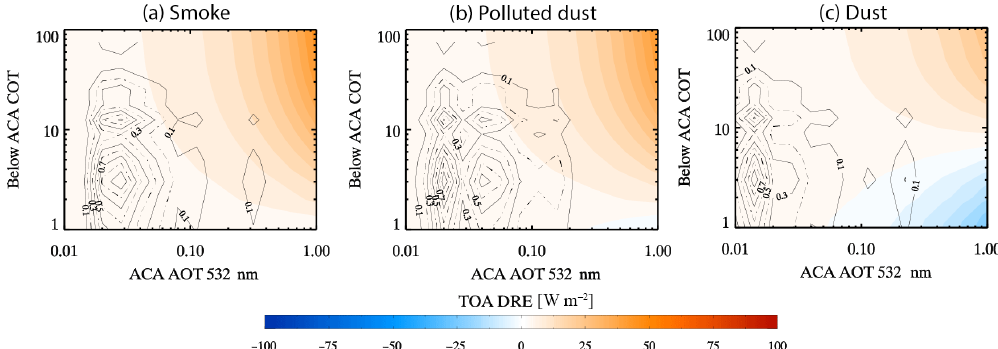
Figure 13. Same as Fig. 9 but for the (a) smoke, (b) polluted dust and (c) dust aerosols in the Northwest Pacific Ocean.